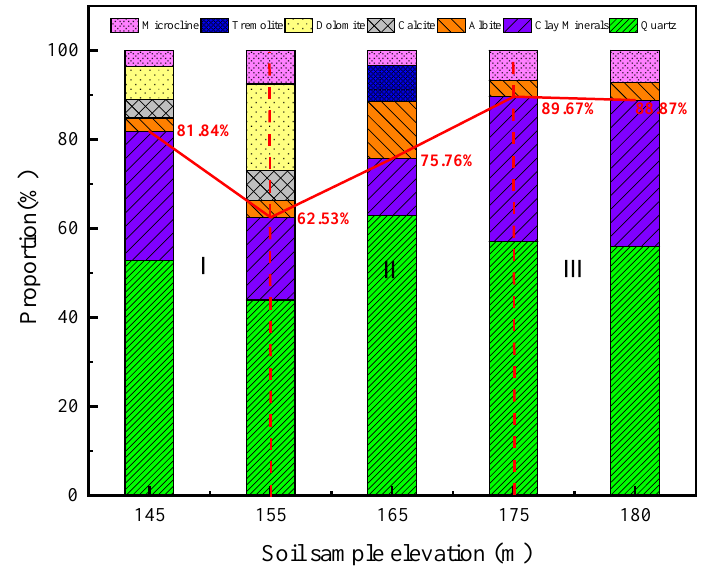
Figure 8. Mineral composition of soil at different elevations. A MacroMR12-150H-1 NMR analyzer was used to test the samples after cyclic loading and unloading, and the pore size characteristics of the soil at different elevations were obtained. According to the dry density of the soil mass, the corresponding volume mass was weighed, and the soil mass was pressed into a PVC pipe with a diameter of 50 mm and a height of 20 mm. The PVC pipe was used to prevent the interference of nuclear magnetic signals, and it was used in conjunction with the nuclear magnetic resonance testing equipment. The pore size distribution was tested using core analysis software, and the pore sizes were defined as different pore types, i.e., small pores (0–1 µm), medium pores (1–10 µm), and large pores (10–25 µm). Through calculation, the proportion of different types of pores is obtained, and the test and calculation results are shown in Figure 9.